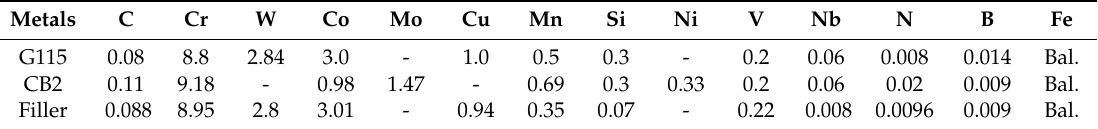
Table 1. The chemical composition of the base metals and filler wire